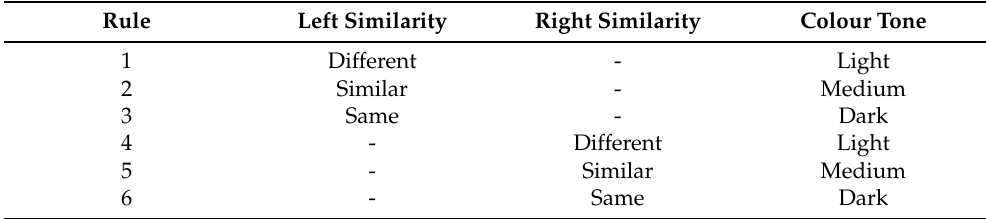
Table 3. The rules of the FIS. The neighbouring similarity of the pixels to the left and the right affects the colour tone. Rule Left Similarity Right Similarity Colour